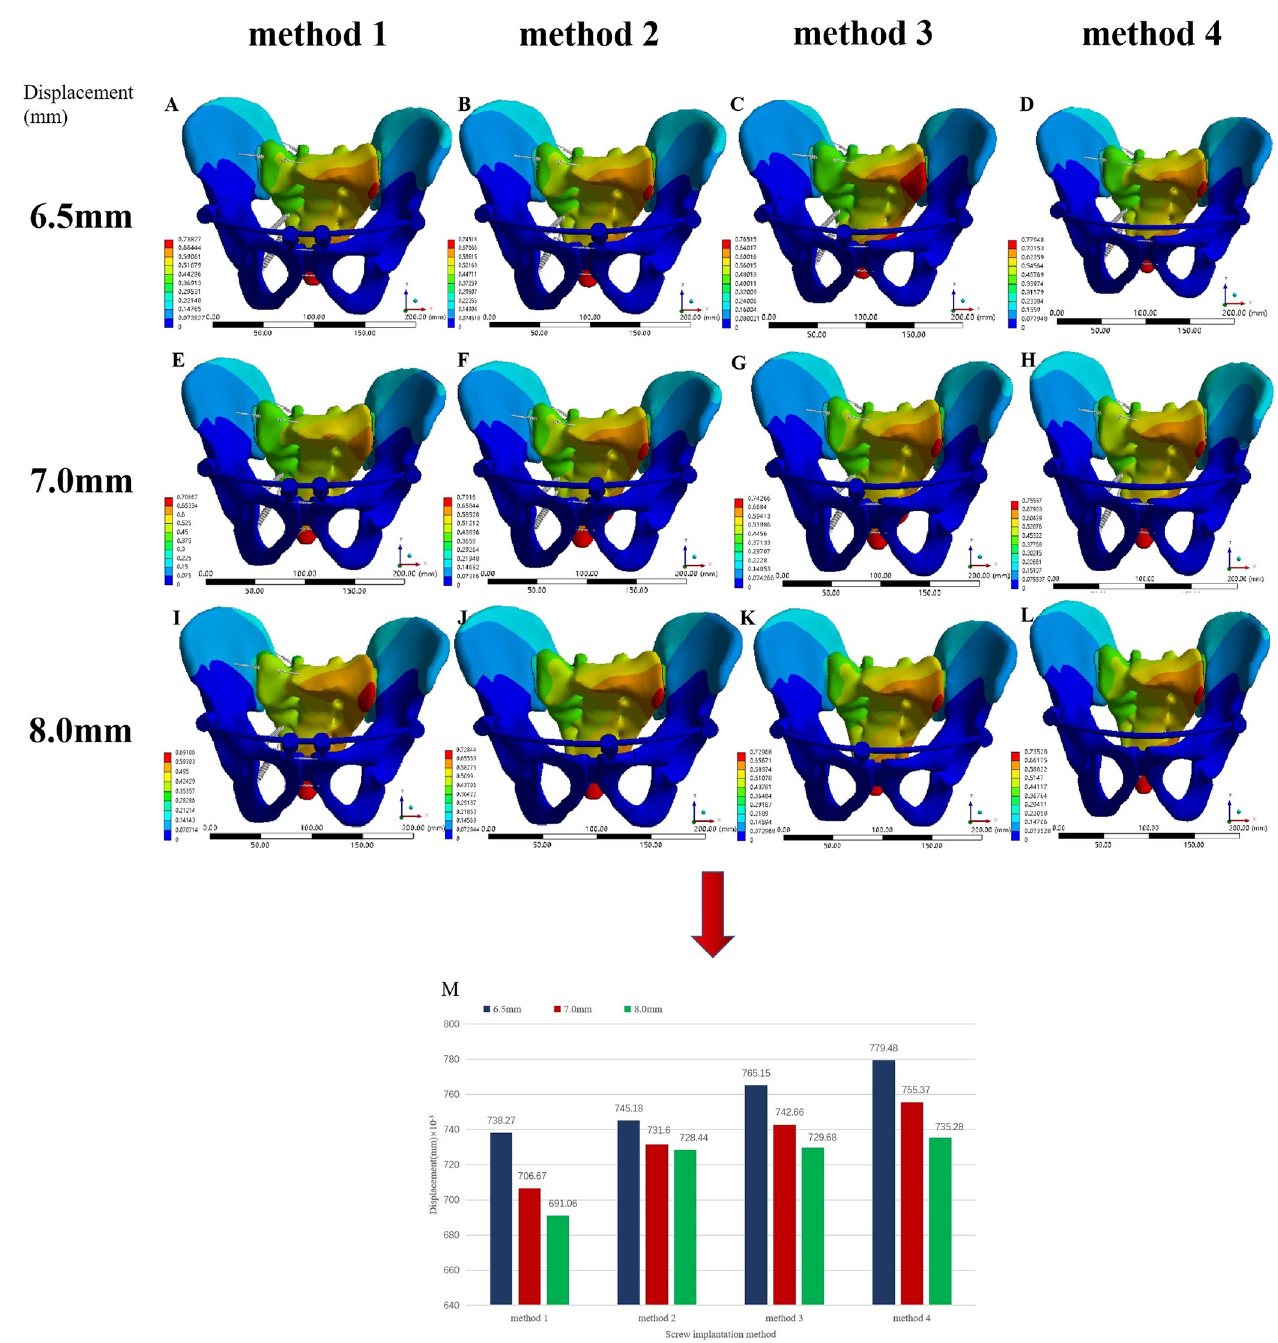
Fig 6. Displacement distribution of pelvic models fixed with pedicle screws under a vertical load. (A) Model 4. (B) Model 5. (C) Model 6. (D) Model 7. (E) Model 8. (F) Model 9. (G) Model 10. (H) Model 11. (I) Model 12. (J) Model 13. (K) Model 14. (L) Model 15, (M) Comparison of the maximum displacement of the pelvic model with pedicle screws of three diameters and four fixation methods under a vertical load. fixation stress (13.23 MPa) and Model 12 the smallest overall maximum stress (11.7 MPa); its value was much smaller than that of the steel plate fixation model. In the case of the same ante- rior pelvic ring screw placement, the maximum stress of the whole pelvis (ilium) and internal